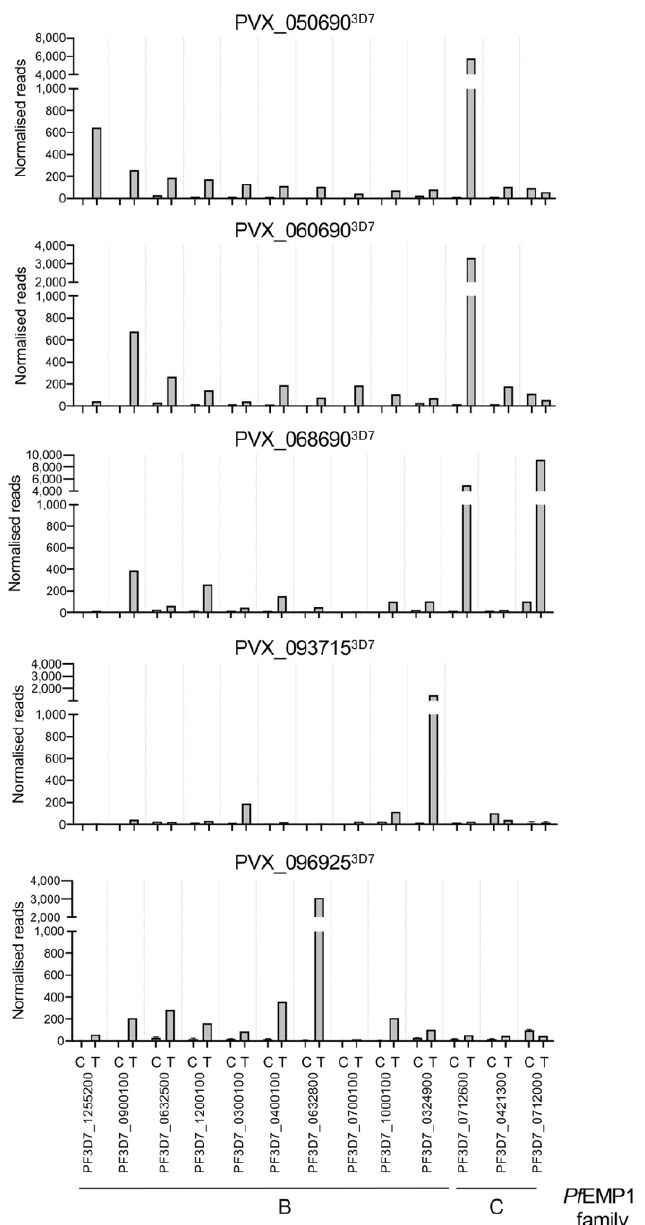
Figure 5. Expression of var genes differentially expressed in ring stage P falciparum 3D7 transfectants (T) in comparison to non-transfected 3D7 parasites as control (C). The normalized reads are the mean values of two transcriptome analyses derived from two independent biological samples. Exceptions are PVX_093715 3D7 and PVX_096925 3D7 with only one biological sample (Tables S1–S10). B: Pf EMP1 family B; C: Pf EMP1 family C.